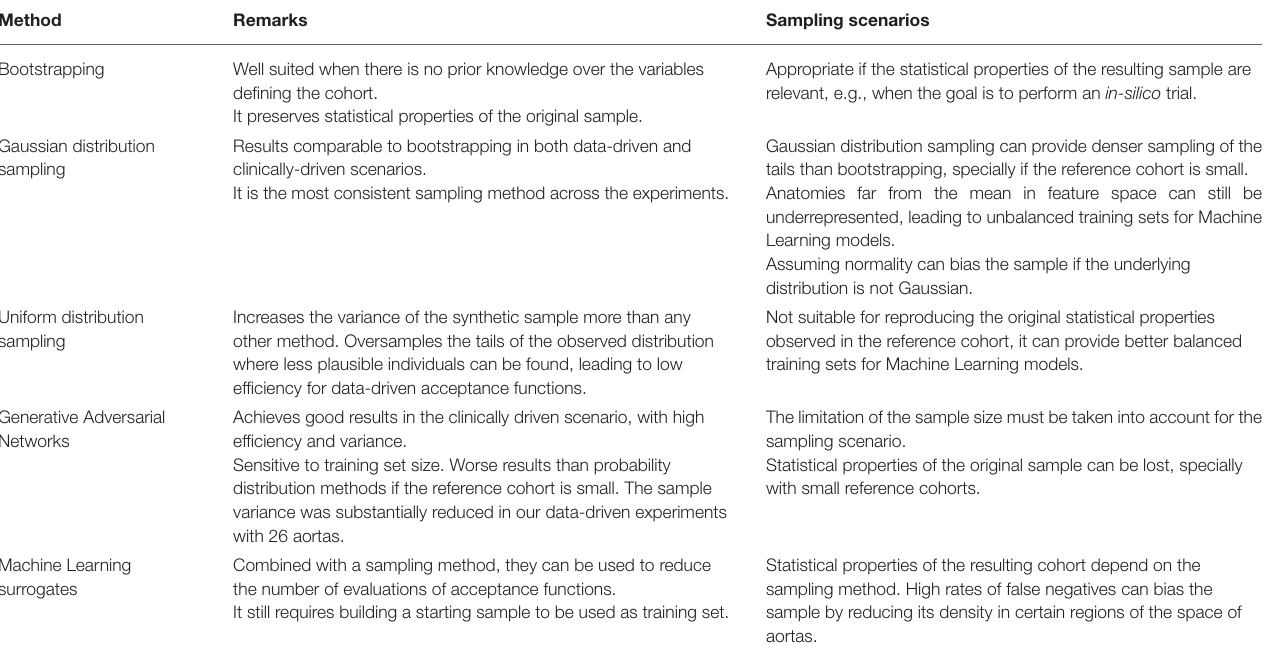
TABLE 6 | A summary of the conclusions that can be obtained from the results of the study presented in this